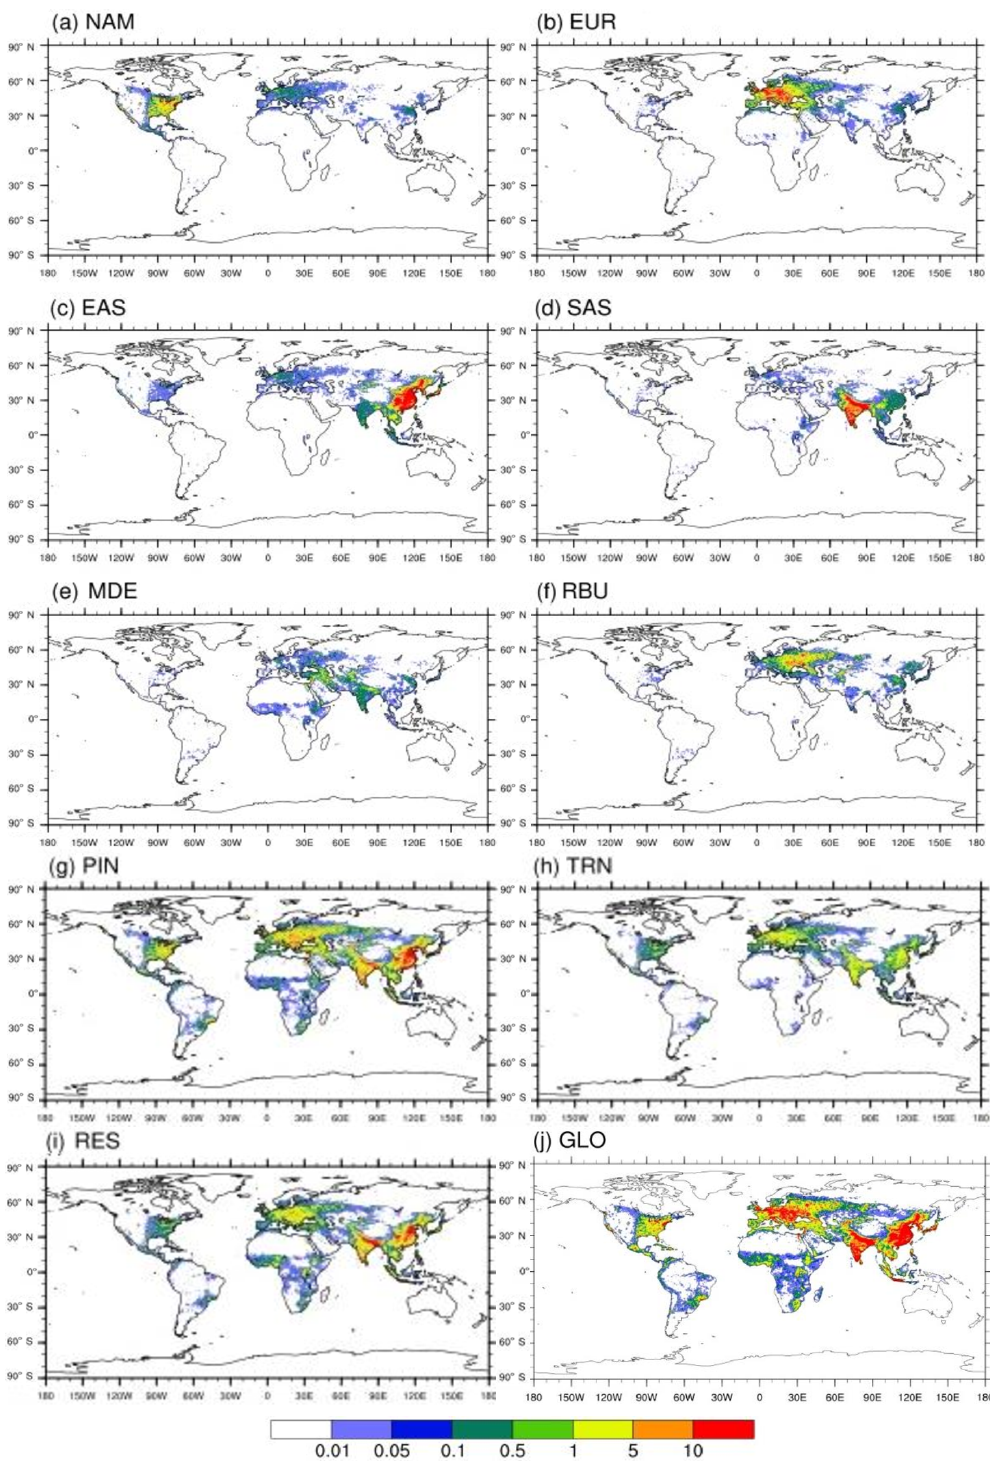
Figure 5. Annual avoided PM 2 . 5 -related premature deaths in 2010 per 1000km 2 due to 20% emission reduction scenarios relative to the base case in (a) North America (NAM), (b) Europe (EUR), (c) East Asia (EAS), (d) South Asia (SAS), (e) the Middle East (MDE), and (f) Russia–Belarus–Ukraine (RBU), the (g) power and industry (PIN), (h) transportation (TRN), and (i) residential (RES) sectors, and (j) globally